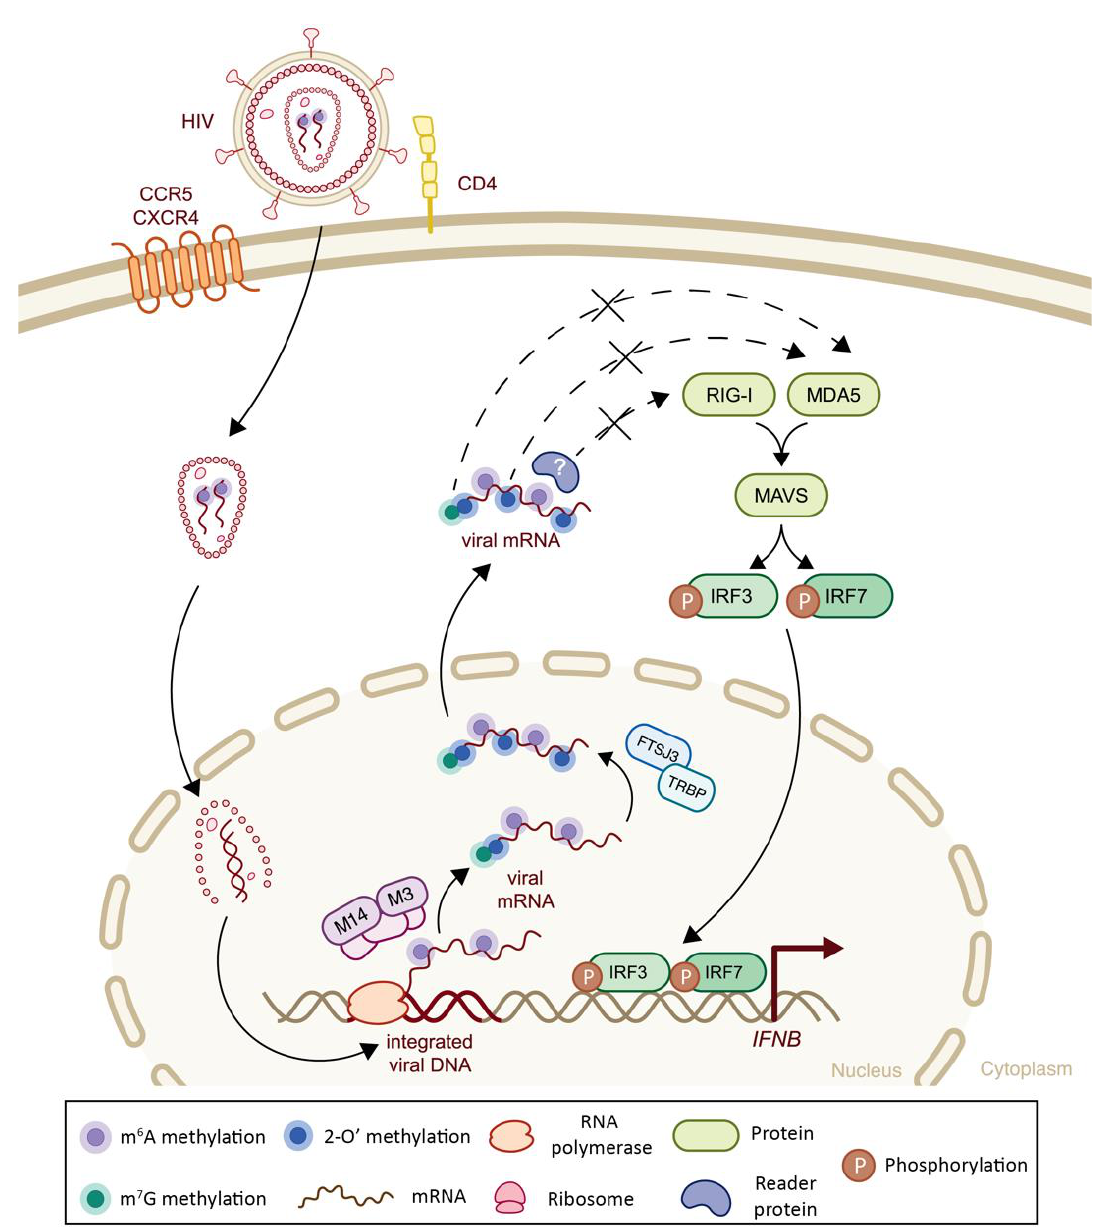
Figure 6. The impact of epitranscriptomic methylations on IFN-I response during HIV infection. After cellular entry, human immunodeficiency virus (HIV) reverse-transcribes its RNA genome into viral dsDNA and subsequently integrates into the host chromatin. The newly transcribed viral RNAs contain a complete cap structure (m 7 G and 2 (cid:48) -O methylations at its 5 (cid:48) end, filled green and blue circles, respectively) that is catalyzed by virally hijacked host capping machinery (not shown). Viral transcripts also hold internal 2 (cid:48) -O methylations (filled blue circles) that are catalyzed by FTSJ3 2 (cid:48) -O- Mtase, which is previously recruited by the TAR binding protein TRBP. Both capping and internal 2 (cid:48) -O methylations are involved in impairing MDA5 sensing. HIV mRNA is also m 6 A-methylated (filled purple circles) by the cellular m 6 A machinery, resulting in RIG-I sensing and further IFN β signaling impairment. M3: METTL3 ; M14: